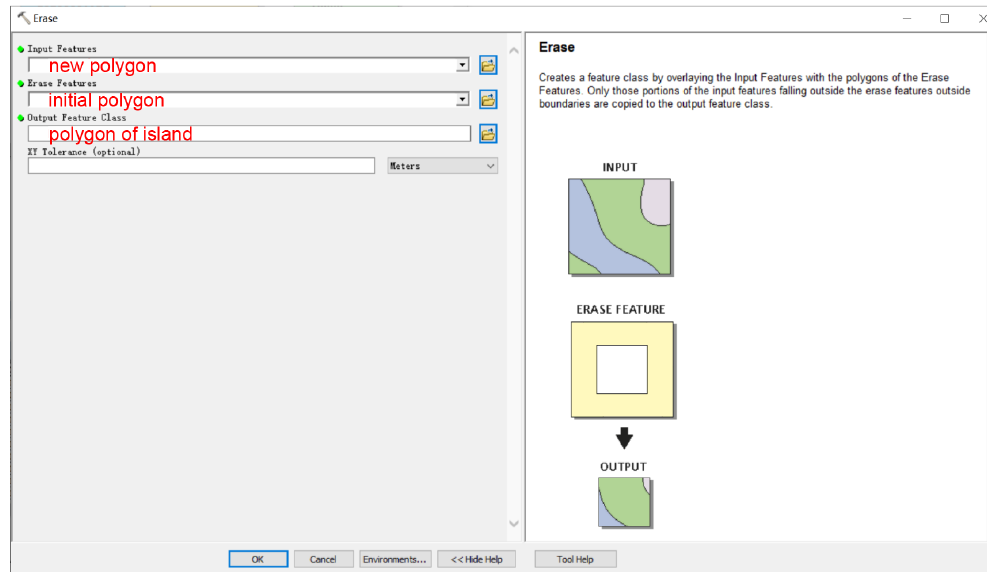
Figure A7. Erase tool in